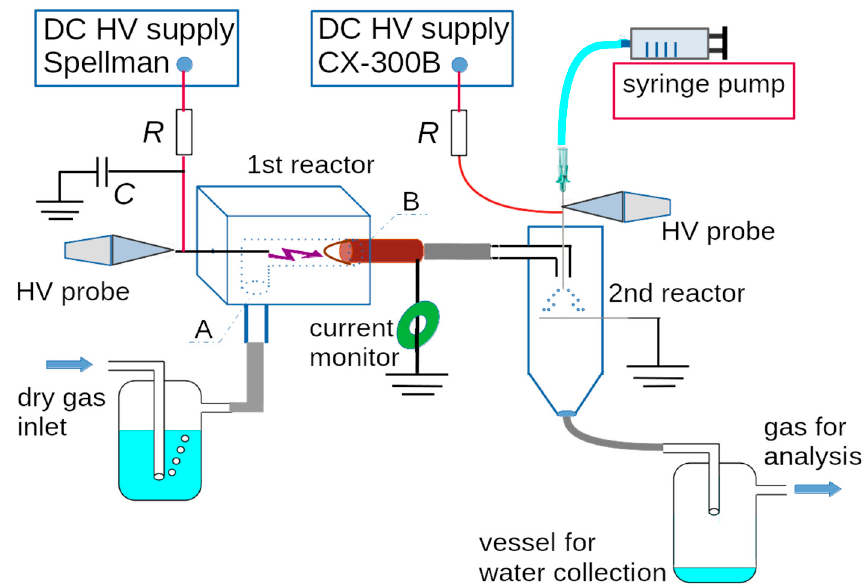
Figure 2. Simplified schematic of the experimental setup of two-stage system (2SS), with the first reactor for TS generation and the second reactor for water electrospray (ES); R —resistor, C —capacitor, HV—high voltage, A—opening for the gas inlet, B—opening for the gas outlet and insertion of the grounded electrode.